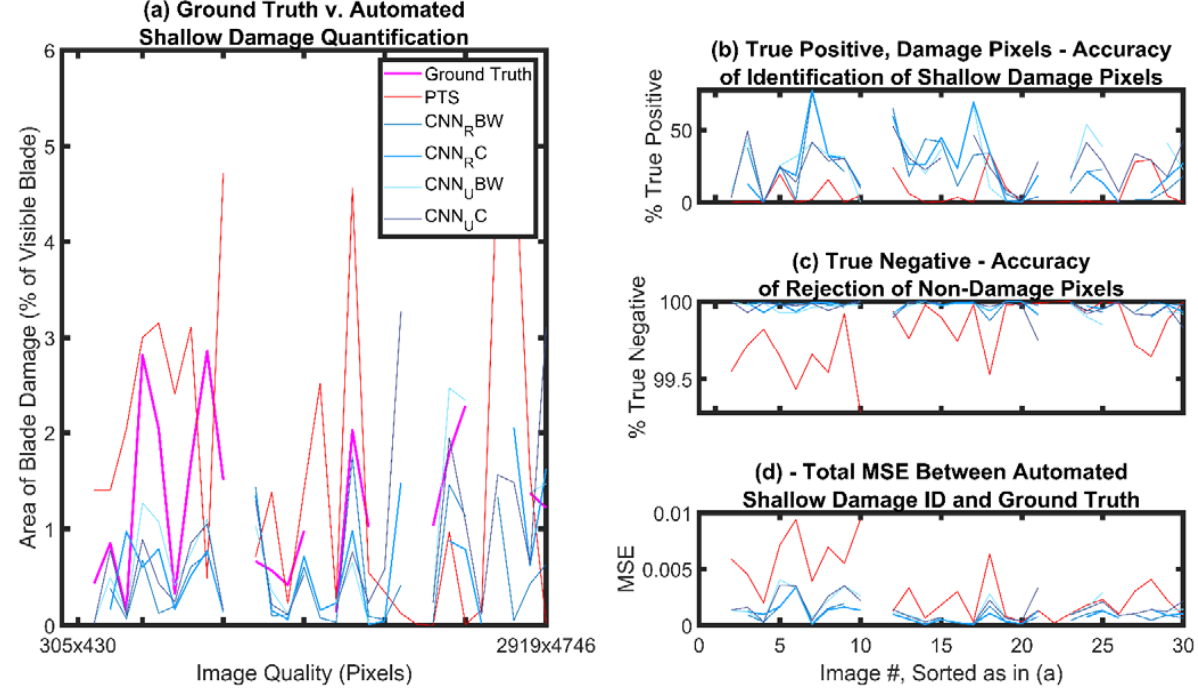
Figure 13. ( a ) Automated shallow LEE quantification results for the unsupervised PTS module (red) and supervised CNN modules (blue) compared to subjective quantification for shallow damage (magenta). ( b ) Accuracy of automated identi fi cation of shallow LEE pixels compared to subjective identi fi cation. ( c ) Accuracy of rejection of non-LEE pixels compared to subjective identi fi cation (higher accuracy denotes fewer false positives in pixels assigned to the shallow LEE class, i.e., less noise). ( d ) Total mean square error between automated and subjective shallow LEE pixel identi fi cation.